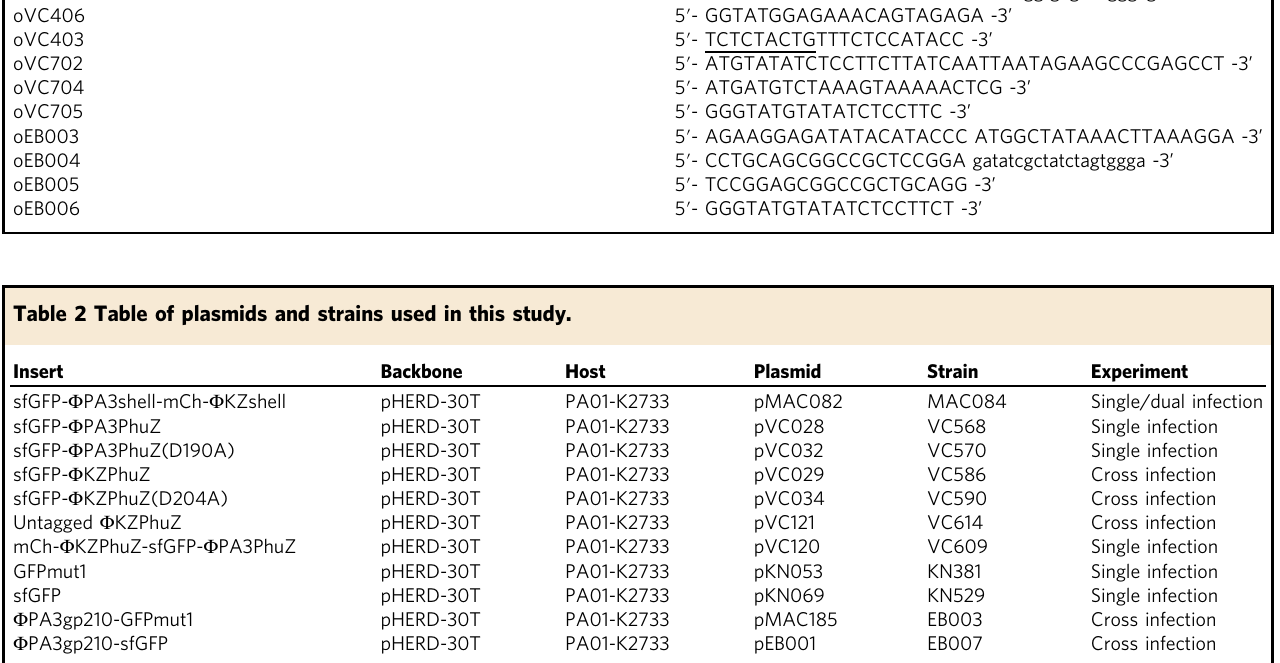
optimize genetic exchange by way of speciation in order to enhance the supply of adaptive variation while minimizing the in fl ux of incompatible genes.